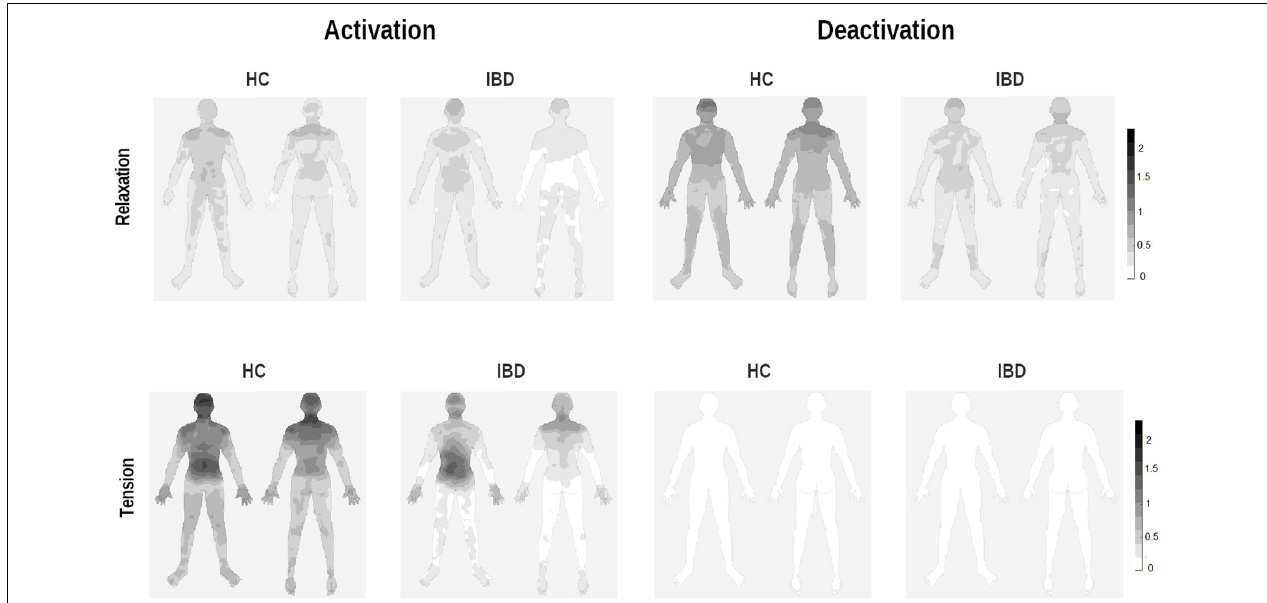
FIGURE 4 | Whole-body topographies visualizing perceived activation and deactivation for the experience of relaxation and tension in HC participants and IBD patients (0 = “no activation/deactivation”; 4 = “very strong